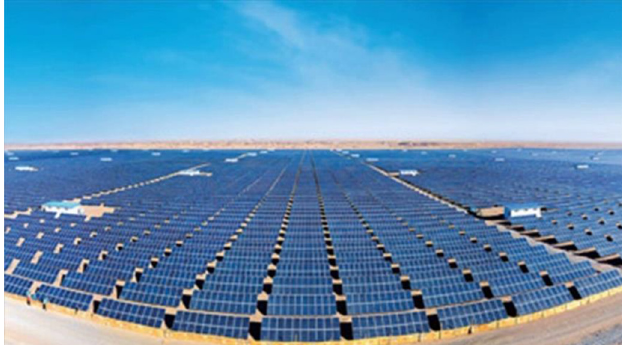
Fig. 17. A very large PV farm, Longyangxia Dam Solar Park in Qinghai province (cid:1) China. Table 4. Selected countries with Photovoltaic capacity at the end of 2019. No.